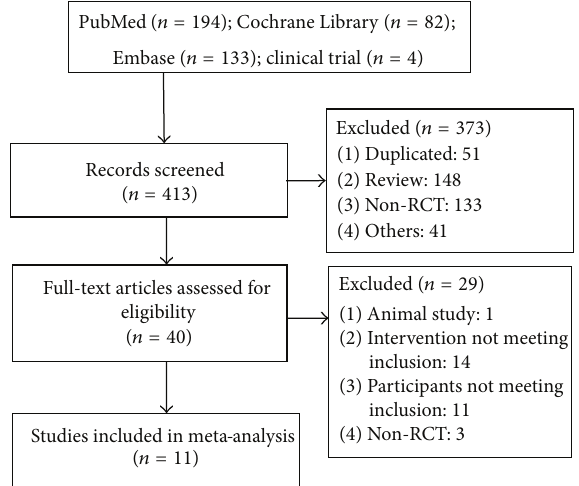
Figure 1: Flow diagram of trial